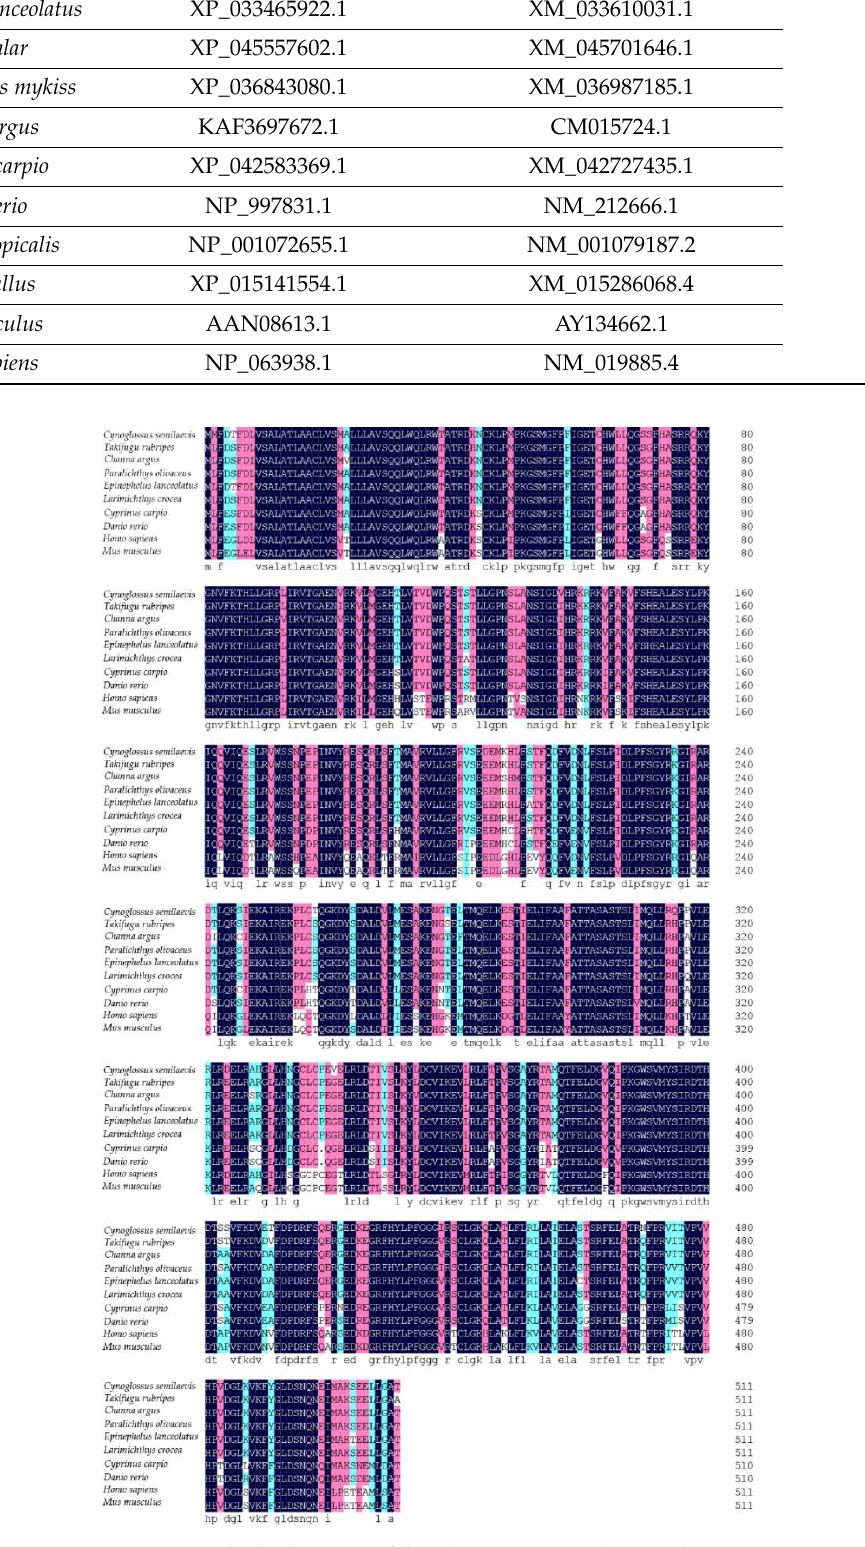
Figure 2. Multiple alignment of the Chinese tongue sole Cyp26b1 protein sequences with other ver- tebrates. The consensus residues are in black, the residues that are ≥75% identical among the aligned sequences are in pink, and the residues that are ≥50% identical among the aligned sequences are in blue .